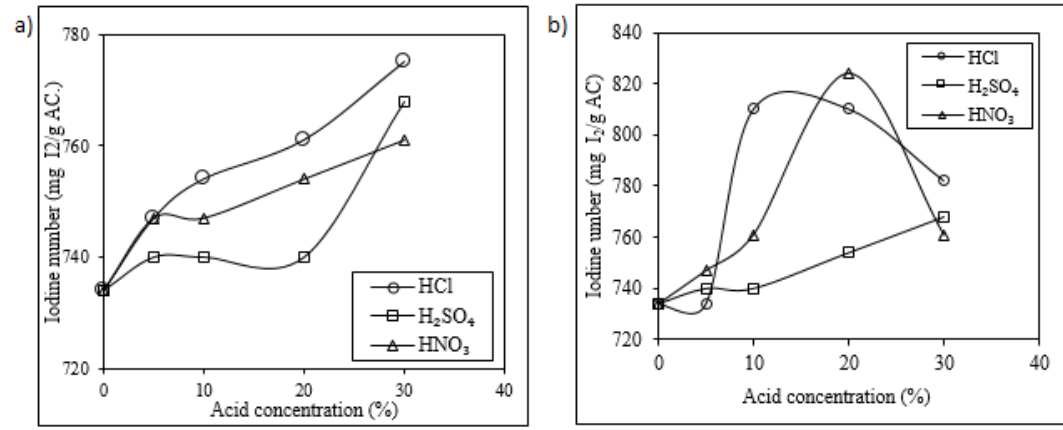
Figure 1. Influence of the concentration (5%, 10%, 20%, and 30% v / v ) of acids (HCl, H 2 SO 4 , and HNO 3 ) on the iodine number (mg I 2 /g AC) at ( a ) 18 °C and ( b ) 50 °C for spent activated carbon (SAC) subjected to a chemical reactivation by acid wash.